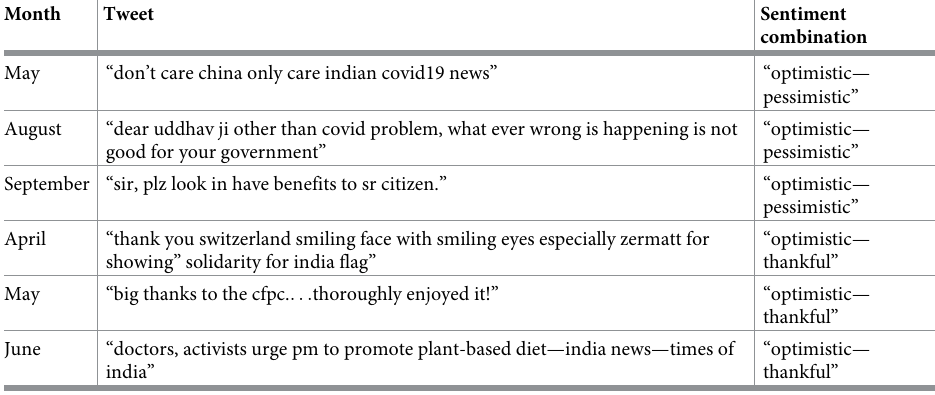
Table 5. Selected example that show cases of tweets that are “optimistic” and also “pessimistic”, along with cases that are “optimistic” and also